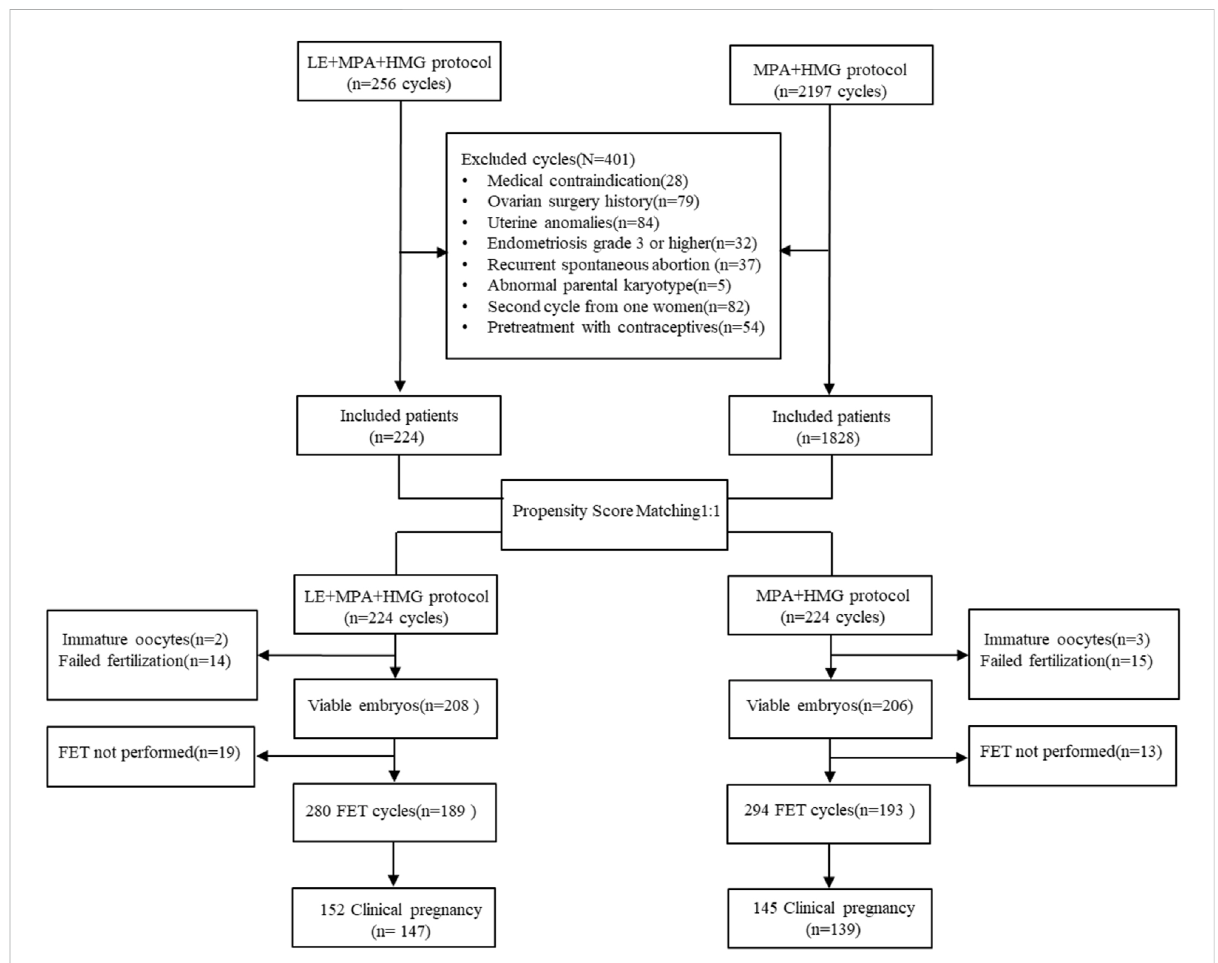
FIGURE 1 Flow chart of the study. IVF: In vitro fertilization; ICSI: Intracytoplastic sperm injection; FET: Frozen embryo transfer; LE: Letrozole; MPA: Medroxyprogesterone acetate; HMG: Meno-trophin for